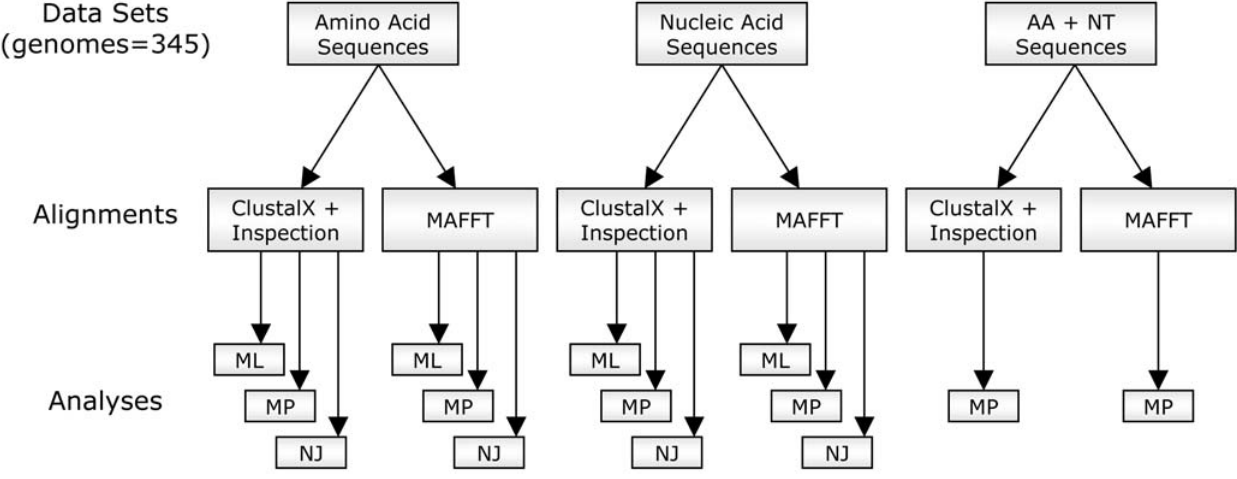
Figure 2. Flow Chart of the Evolutionary Analyses Performed in This Study. ML: maximum likelihood; MP: maximum parsimony; NJ: neighbor joining; MAFFT: multiple sequence alignment based on fast Fourier transform.